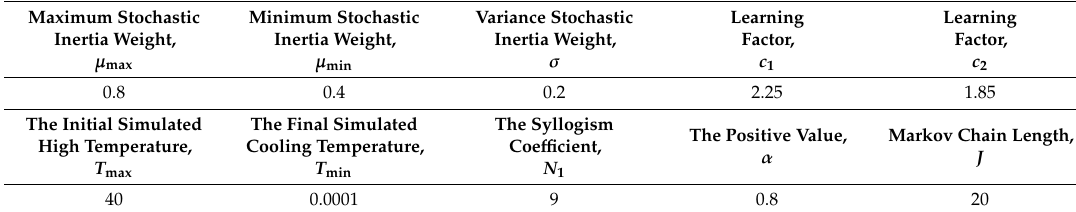
Table 3. Coe ffi cients of modified PSO-modified very fast simulated annealing (MVFSA).